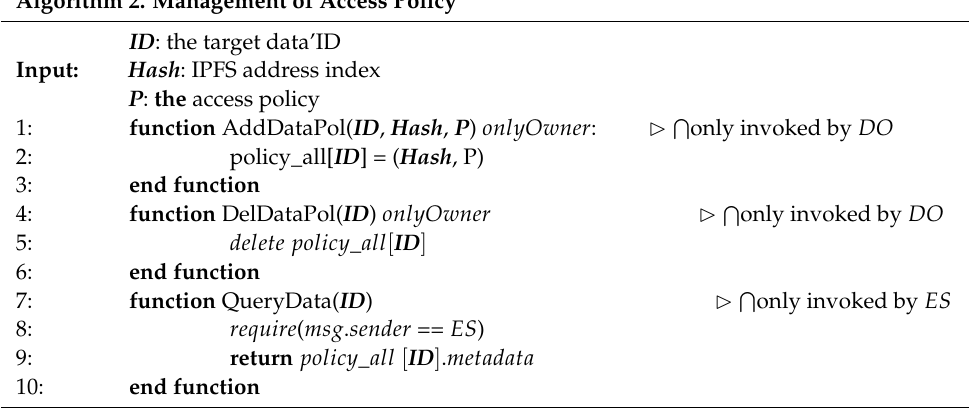
Algorithm 2. Management of Access